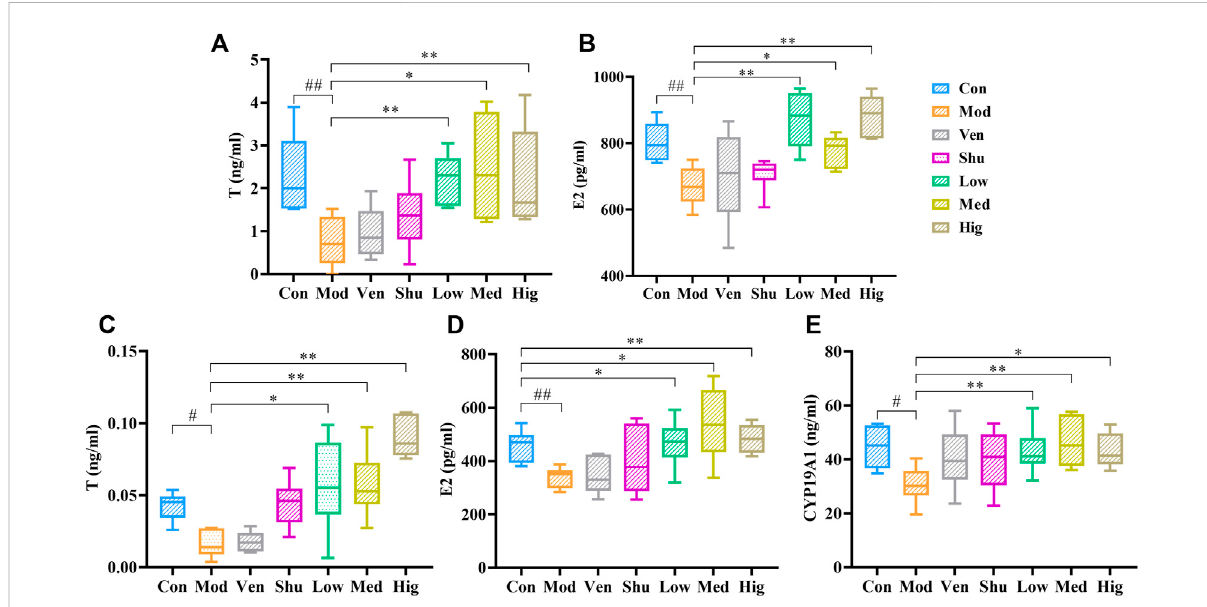
FIGURE 3 The effect of Chaigui granule on sex hormones. (A) The T (mg/ml) levels in serum. (B) The E2 (pg/ml) levels in serum. (C) The T (mg/ml) levels in hippocampus. (D) The E2 (pg/ml) levels in hippocampus. (E) The CYP19A1 (ng/ml) level in hippocampus. All data were expressed as mean ± SD. # p < 0.05 compared with Control group. ✻ p < 0.05, ✻✻ p < 0.01 compared with Model